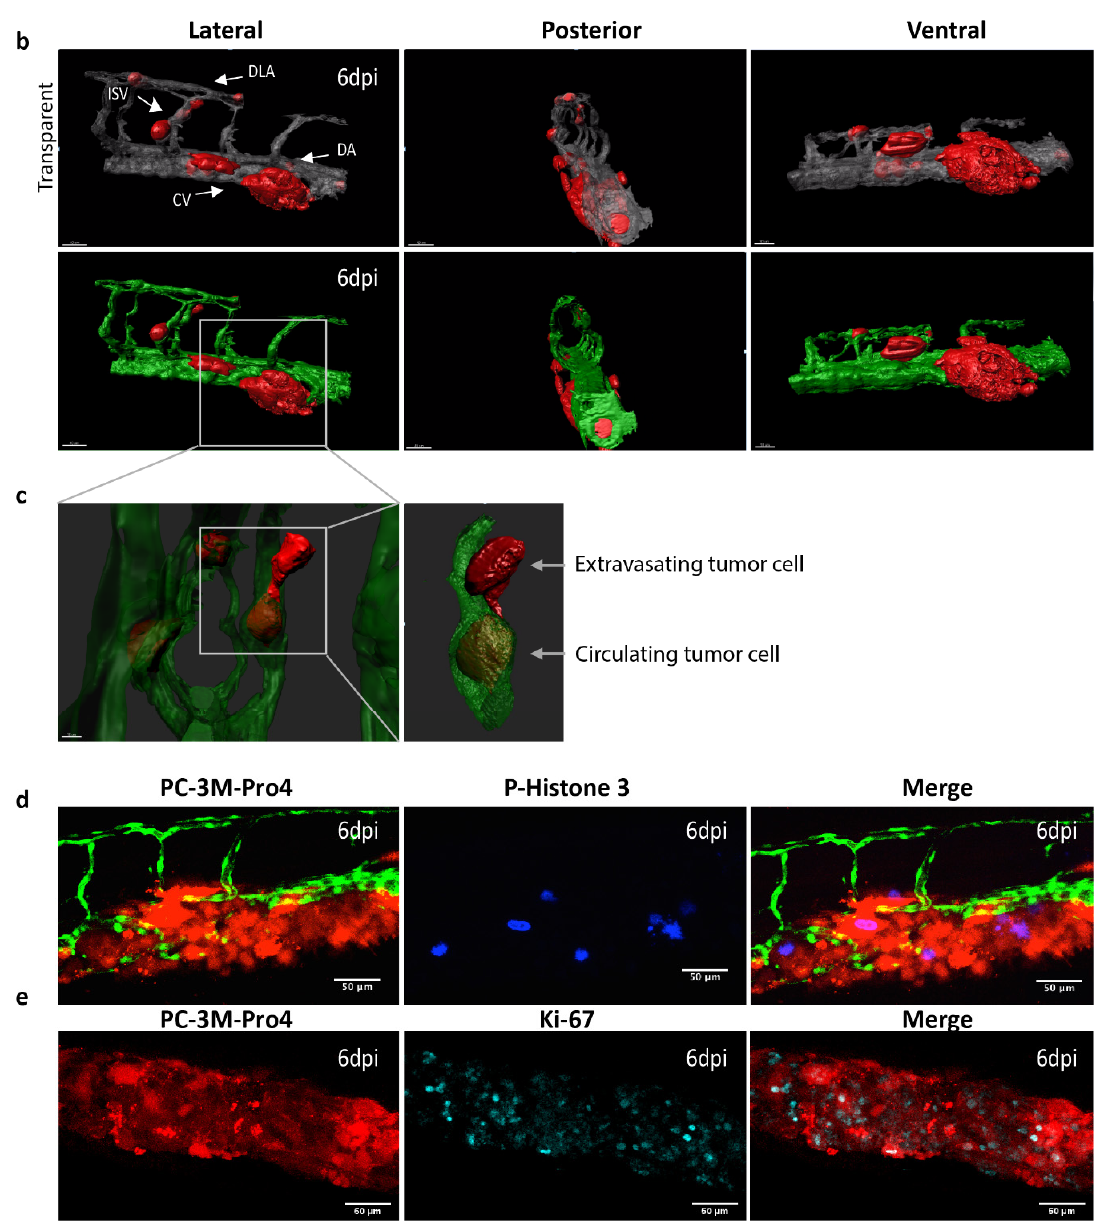
Figure 1. Intravenous transplantation of prostate cancer (PCa) cells induces extravasation and perivascular metastasis formation. ( a ) Schematic indication of cancer cell engraftment. PC-3M-Pro4- mCherry was injected into zebrafish (ZF) vasculature. Metastases was formed at 6 dpi. Red, cancer cells. Green, vessels. ( b – c ) High-resolution images were acquired using a Light-sheet microscope. Scale bar = 100 um. ( b ) Three-dimensional overview of metastatic phenotype of the cancer cells at 6 dpi. Left, lateral. Middle, posterior. Right, Ventral. Up, solid vessels. Down, transparent vessels. Imaging was acquired using Zeiss Lightsheet Z1 at 40x magnification. Zeiss ZEN software was used for multiview fusion and deconvolution. Image J and Imaris 8.1 were applied for imaging stitching and 3D rendering. ( c ) High-magnification images to show single cell behaviors. Single cells were extravasated from intersegmental vessel (ISV), dorsal longitudinal anastomotic vessel (DLV) and Dorsal vein (DA). Up, solid vessels. Down, transparent vessels. ( d – e ) Whole-mount immunofluorescence against phosphorylated Histone 3 ( d ) and Ki-67 ( e ) at 6 dpi. Images were acquired using confocal. Scale bar =